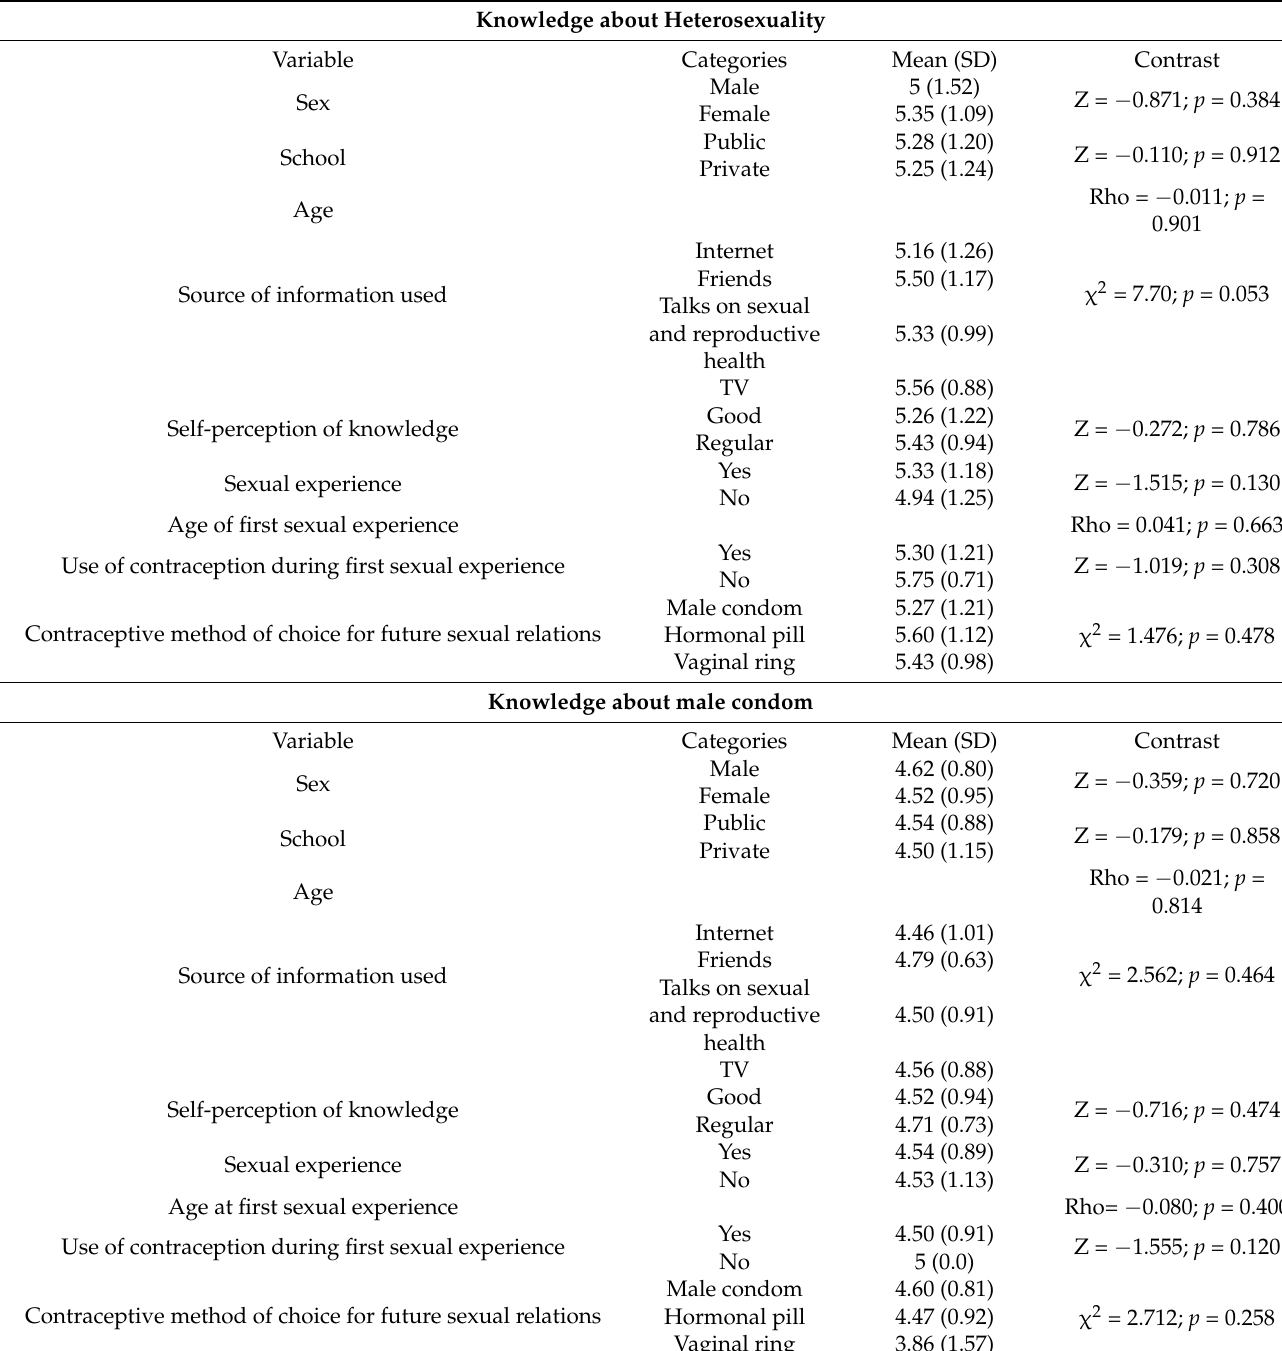
Table 2. Bivariate contrast of the knowledge